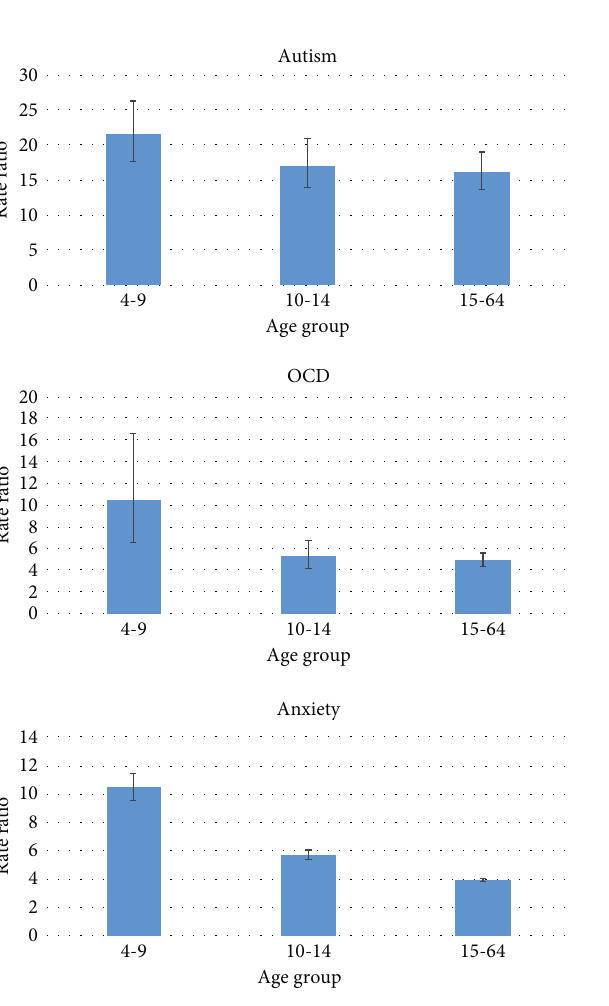
Figure 2: Rate of selected mental health conditions by ADHD case status and bipolar disorder (vs. no bipolar disorder) was 59% higher for males but 25% higher for females ( p = 0 : 0410 ). The rate of injury for ADHD cases with comorbid anxiety (vs. no anxi- ety) was 28% higher for males but 12% higher for females ( p = 0 : 0342 ).